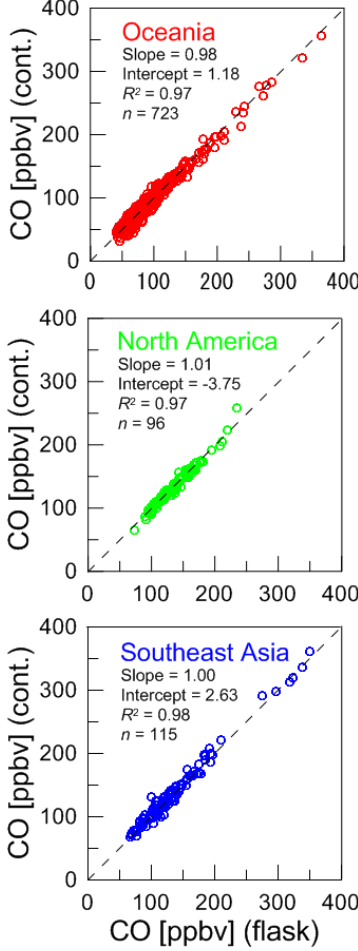
Figure 7. Scatter plots of CO mixing ratios obtained by continuous (cont.) measurements against ratios obtained by flask analyses (flask) for the Oceania, North America, and Southeast Asia route. The dashed lines indicate the 1:1 correspondence lines.